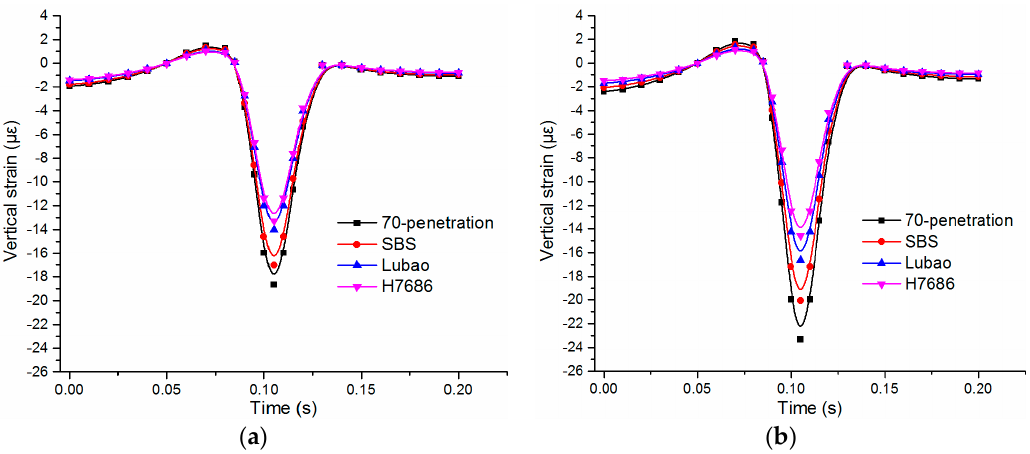
Figure 10. Vertical strains at bottom center of underlayers: ( a ) under standard load; ( b ) under heavy load.